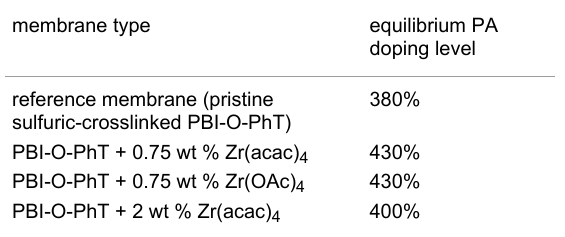
Table 1: Equilibrium phosphoric acid (PA) doping levels for composite PBI-O-PhT